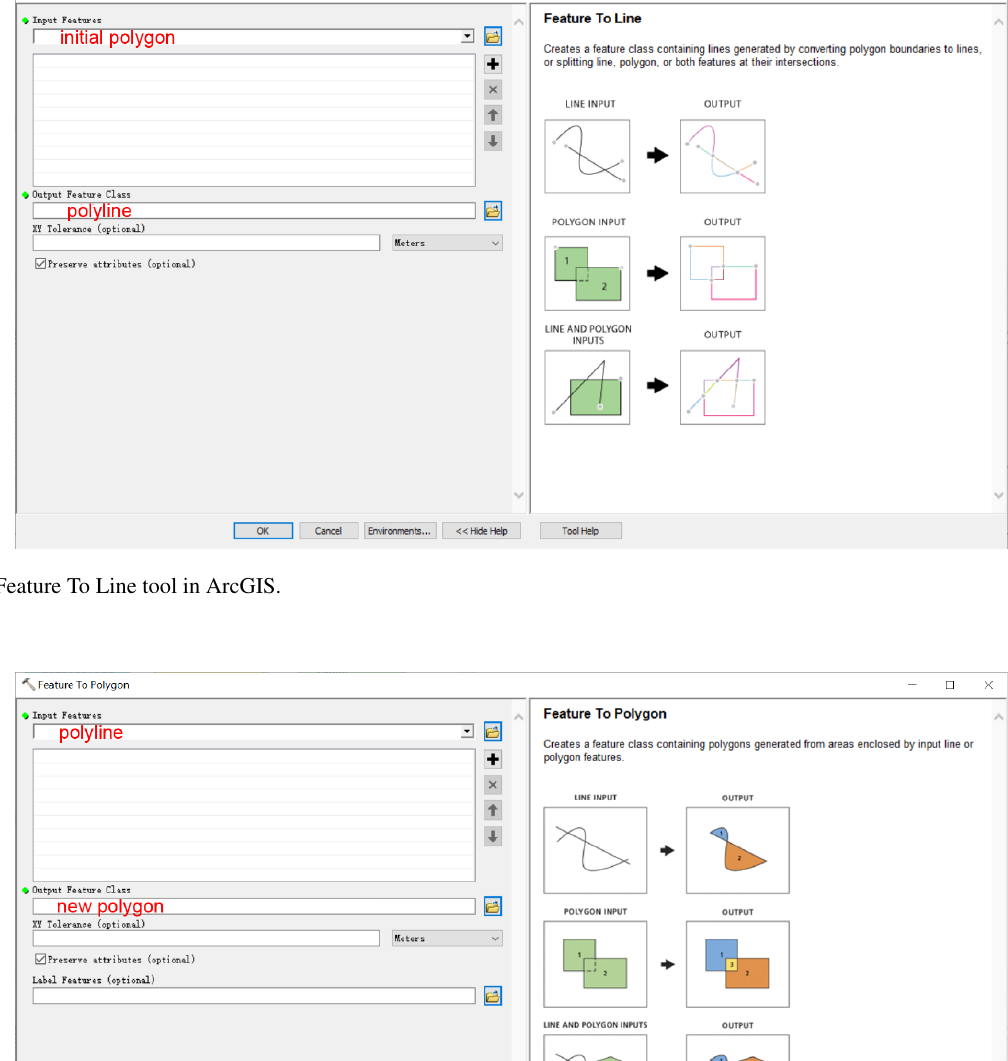
Earth Syst. Sci. Data, 14, 5489–5512,